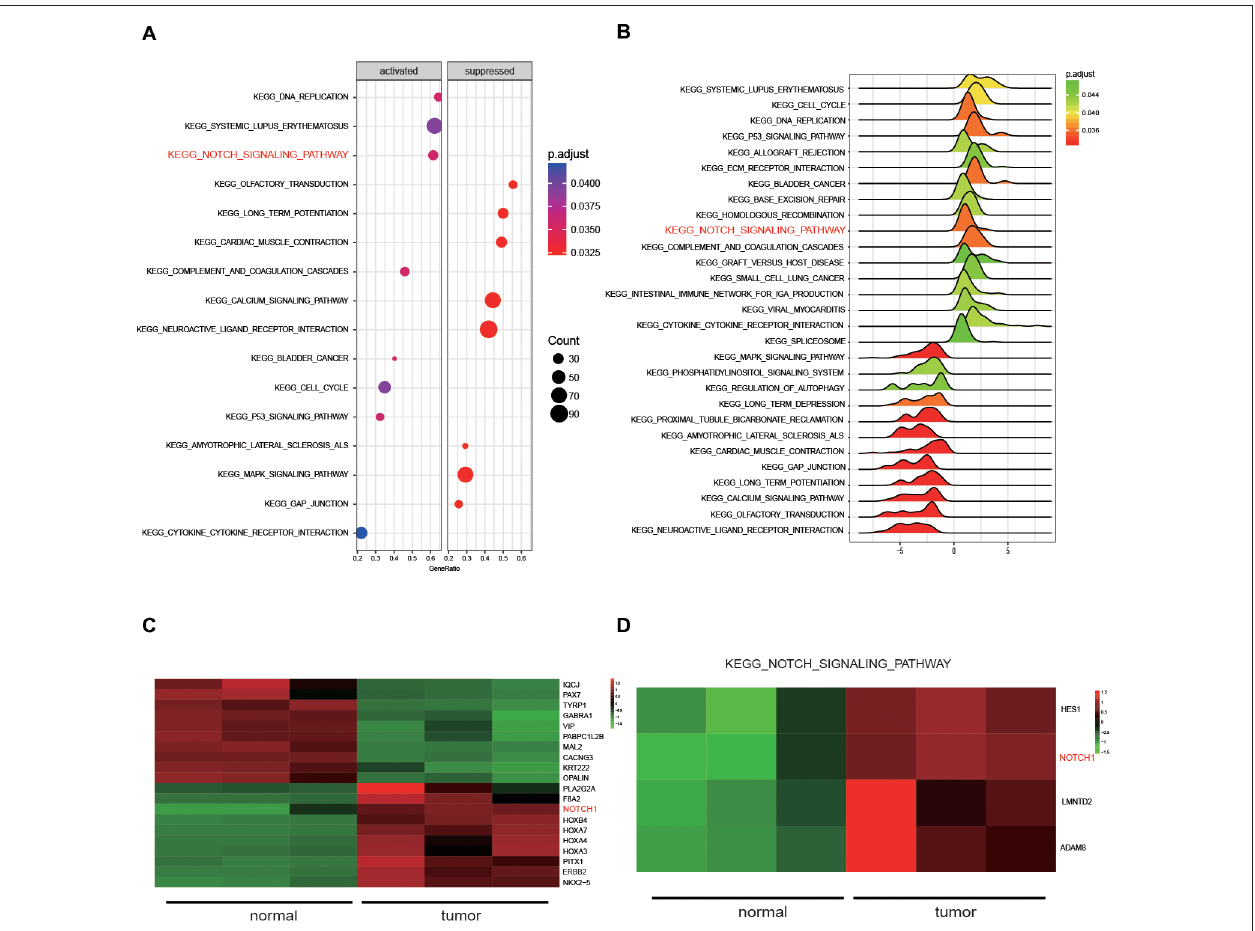
FIGURE 2 | The results of Kyoto Encyclopedia of Genes and Genomes (KEGG) pathway analysis. (A) Dotplot analyzed the enrichment of pathways. (B) Joyplot analyzed the enrichment of pathways. P .adjust value was less than 0.05. (C) The heat map presenting the 20 genes that were differentially expressed in glioma tissues and normal tissues. (D) The differentially expressed genes in the Notch signaling pathway were selected by intersecting the screened differentially expressed genes from glioma tissues with genes in the Notch signaling